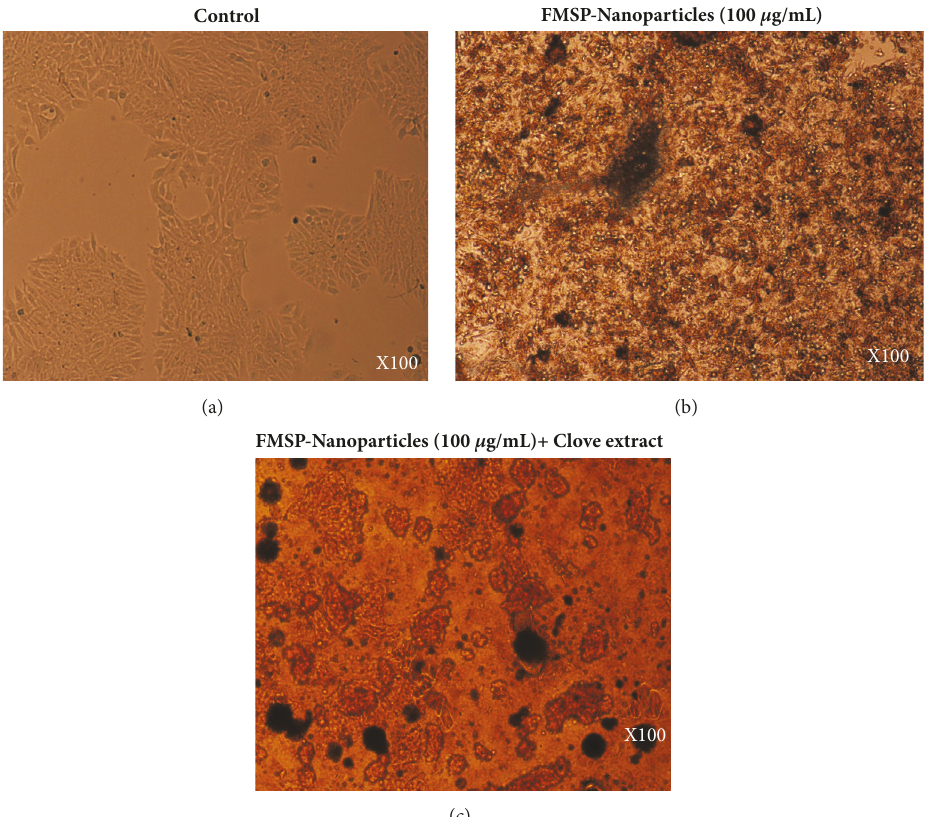
Figure 4: Cell morphology: the MCF-7 cells were analyzed 48 hrs posttreatment. Figure (a) is control; Figure (b) is treated with FMSP- nanoparticles (100 𝜇 g/mL); Figure (c) is treated with FMSP-nanoparticles (100 𝜇 g/mL) + clove extracts (100 𝜇 g/mL). Arrows indicate cell dead cell debris. 100 X